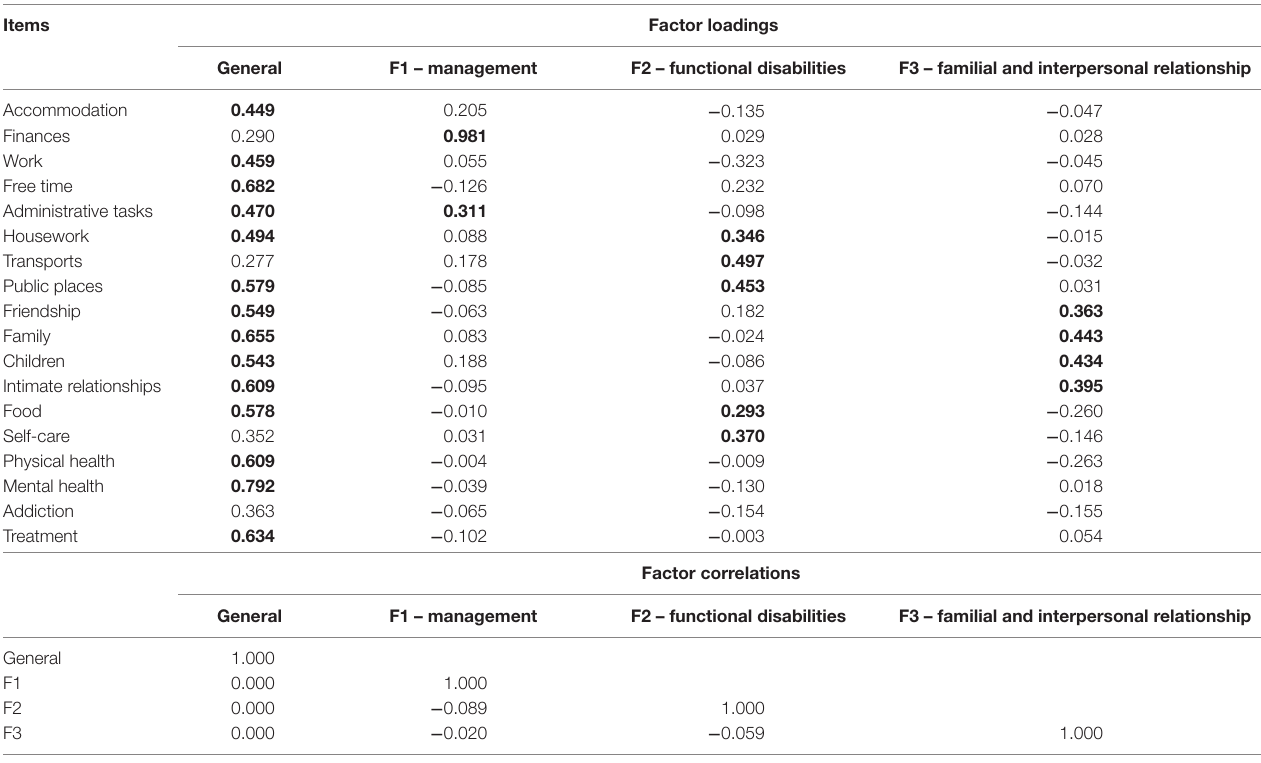
TaBle 4 | Factor loadings for the exploratory four-factor model of needs for care (oblique bi-geomin rotation).